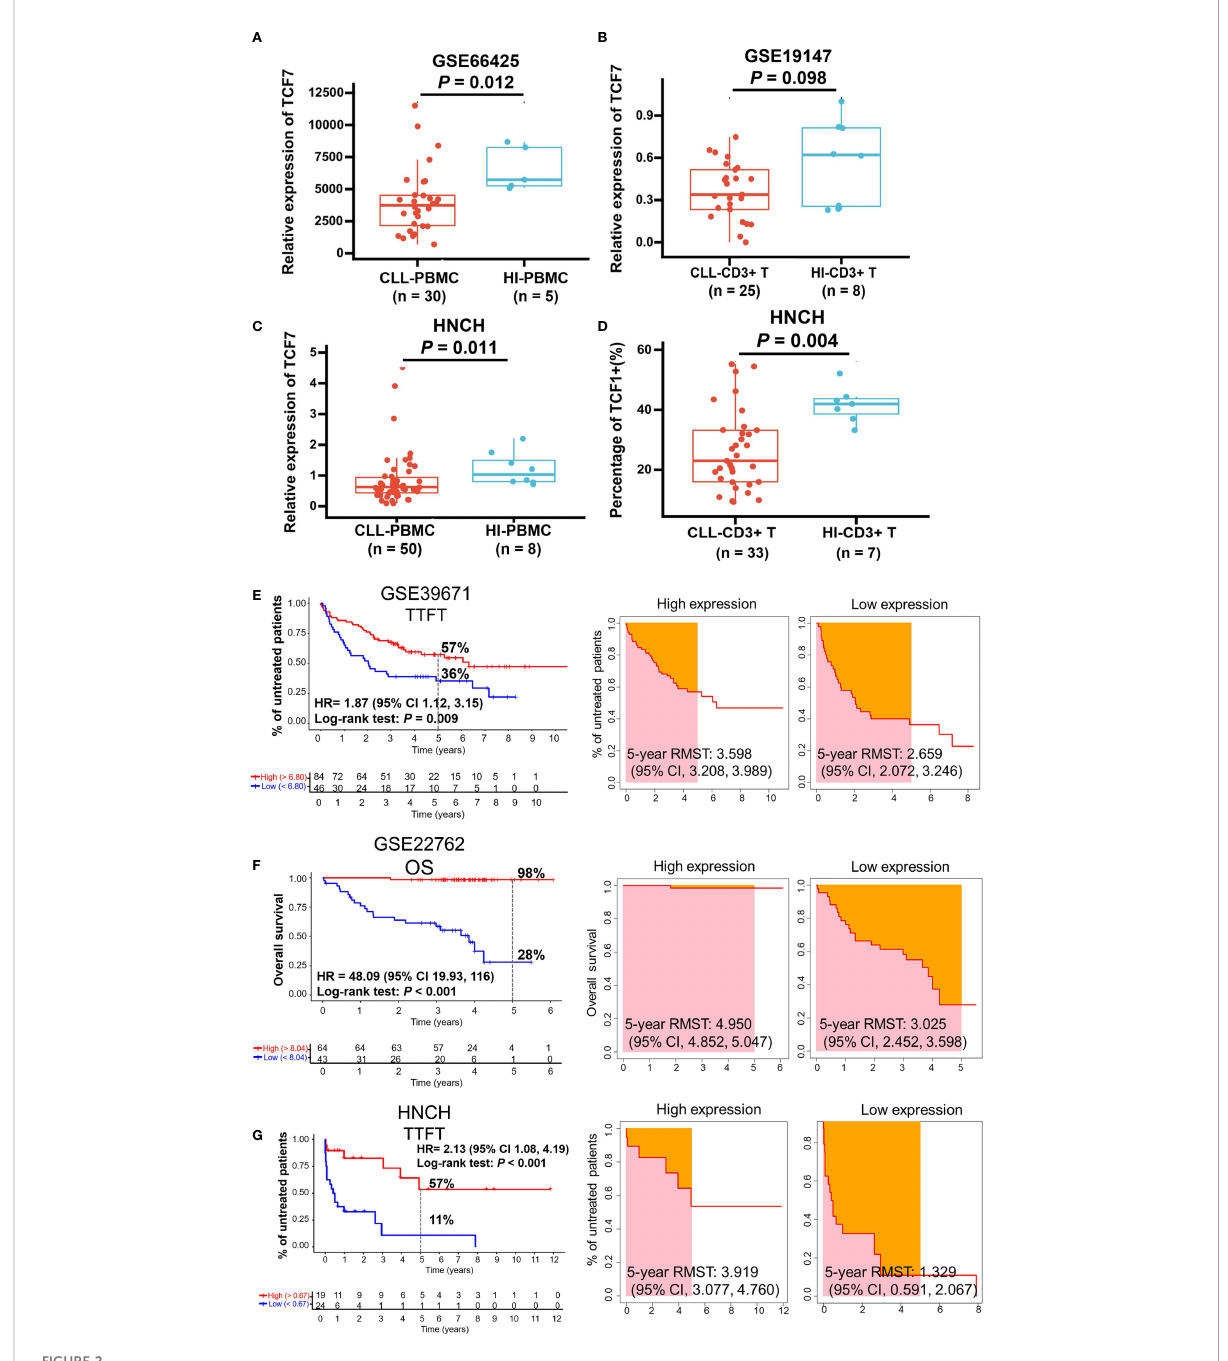
FIGURE 2 The expression and predictive effects of TCF1 on the TTFT and OS for patients with CLL. The expression of TCF1 in PBMCs and CD3+ T cells from CLL patients and healthy individuals (HIs) in the GSE66425 (A) and GSE19147 (B) datasets. (C) qPCR and (D) FCM veri fi ed the results of TCF1 expression in PBMCs and CD3+ T cells from CLL patients and HIs in the HNCH. (E) The TTFT (left panel) and RMST (right panel) for the high and low TCF1 expression groups in the GSE39671 dataset. (F) The OS (left panel) and RMST (right panel) for the high and low TCF1 expression groups in the GSE22762 dataset. (G) The TTFT (left panel) and RMST (right panel) for the high and low TCF1 expression groups in the HNCH. Error bars indicate